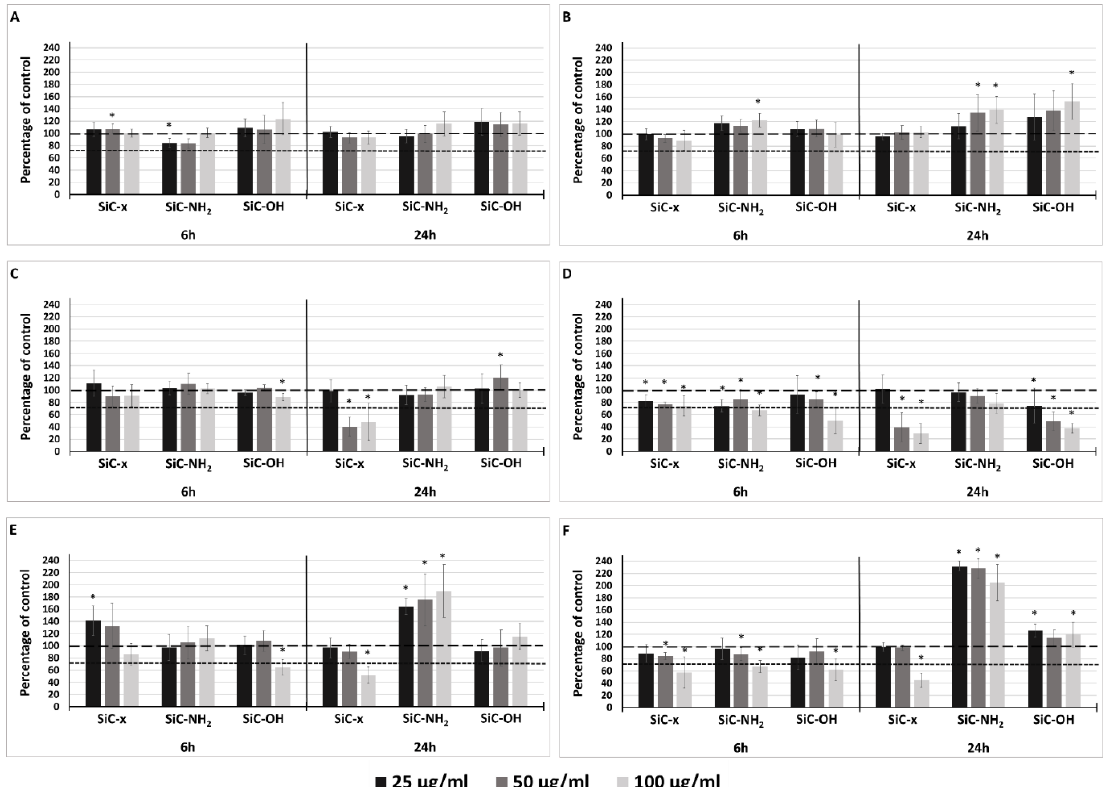
Figure 3. Metabolic activity of human cells treated with SiC-based NPs. Osteoblasts (SAOS-2) ( A , B ), adherent THP-1 (macrophage-like cells) ( C , D ), and suspension THP-1 (monocytic cells) ( E , F ) under standard cultivation conditions ( A , C , E ) and non-standard cultivation conditions ( B , D , F ). The data is presented in the form of means, deviation marks represent the standard deviation, the star symbol (*) denotes statistically significant changes against the control levels (Wilcoxon matched-pairs test, p < 0.05). The long dashed line shows 100% of the untreated control, the short dashed line shows 75% of the untreated control (cytotoxic level).